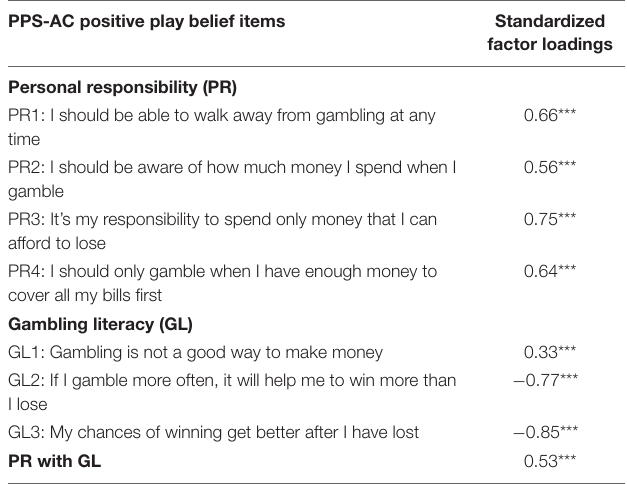
TABLE 2 | Confirmatory factor analysis results of positive play belief items among past-year gamblers ( N = 237). PPS-AC positive play belief